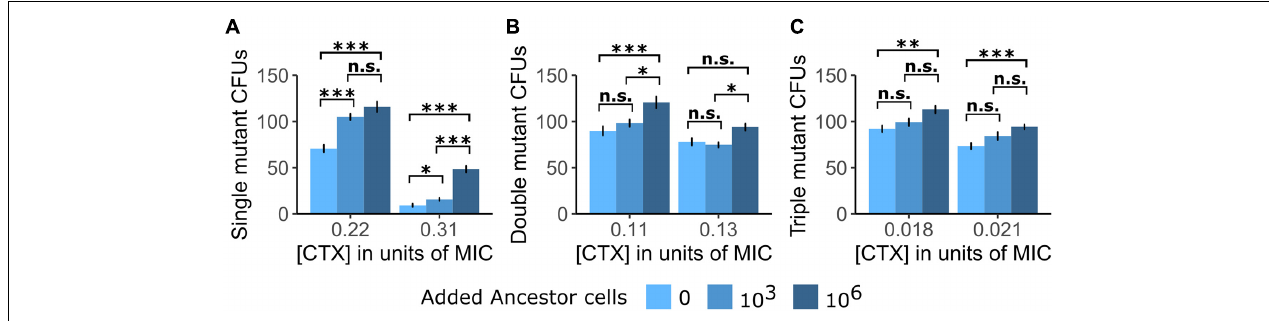
FIGURE 1 | The establishment of single cells into visible colonies of the three tested TEM mutants is shown as counts of colony-forming units (CFUs) of (A) the Single mutant, (B) the Double mutant, and (C) the Triple mutant under exposure to two cefotaxime (CTX) concentrations [shown as a fraction of each mutant strain’s minimum inhibitory concentration (MIC)] in either the absence of Ancestor cells or the presence of Ancestor cells at two different densities. Significance levels based on Tukey’s HSD tests are shown within CTX concentrations, between the number of added Ancestor cells after running two-way ANOVA’s over the whole dataset per mutant strain (cf. Supplementary Table 1 ). n.s., not significant, ∗ p < 0.05, ∗∗ p < 0.01, ∗∗∗ p < 0.001.